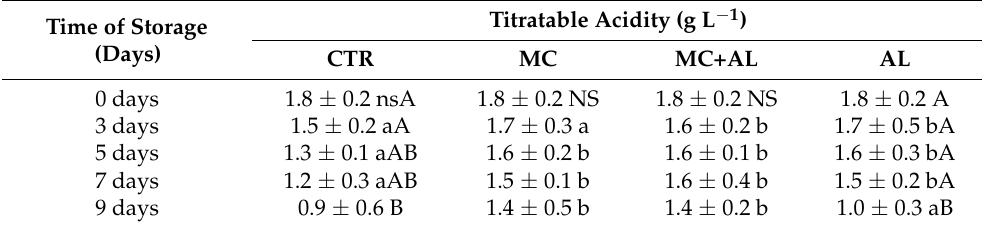
Table 2. Titratable acidity of fruit slices of Actinidia deliciosa (Liang. Ferguson) coated with O. ficus- indica (OFI) mucilage (MC), or mucilage + A. arborescens (MC+AL) or A. arborescens (AL) not treated (CTR), just after being coated (0) and at 3, 5, 7, 9 d of storage at 5 ◦ C. Different lowercase letters indicate significant differences between treatments at each sampling date. Different capital letters indicate significant differences between sampling date for the same treatment. Tukeys’ significant test was applied at p ≤ 0.05. Data are means ± S.E. ( n = 3). Titratable Acidity (g L − 1 Time of Storage (Days)